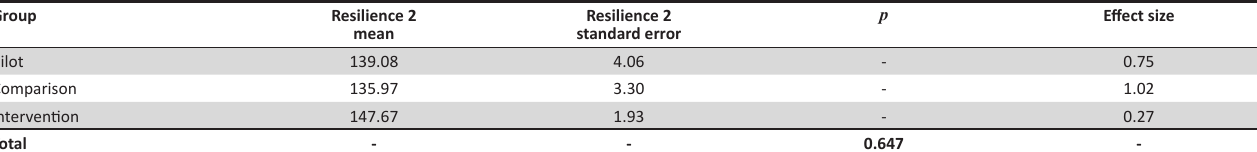
FIGURE 2: Resilience levels of different participating groups before and after sensory stimulation therapy (SST) intervention. TABLE 5: ANCOVA post-test controlling for pretest differences.